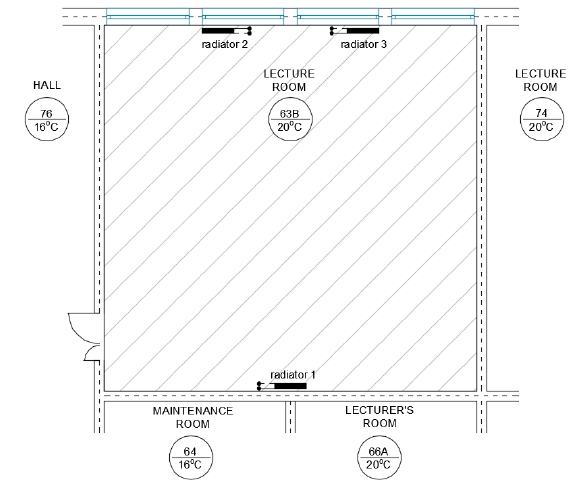
Figure 1. The plan of the analyzed room.